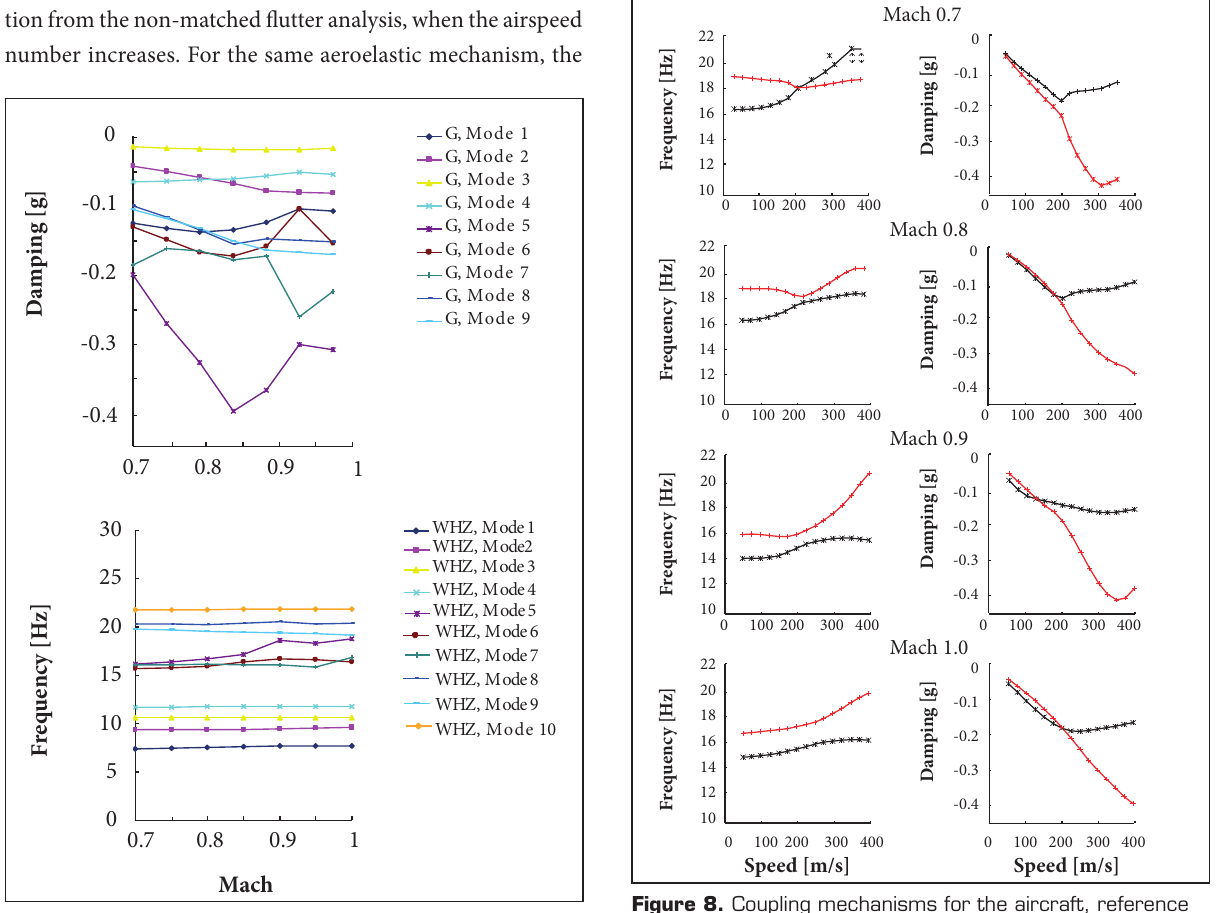
Figure 6. Matched point flutter solution.